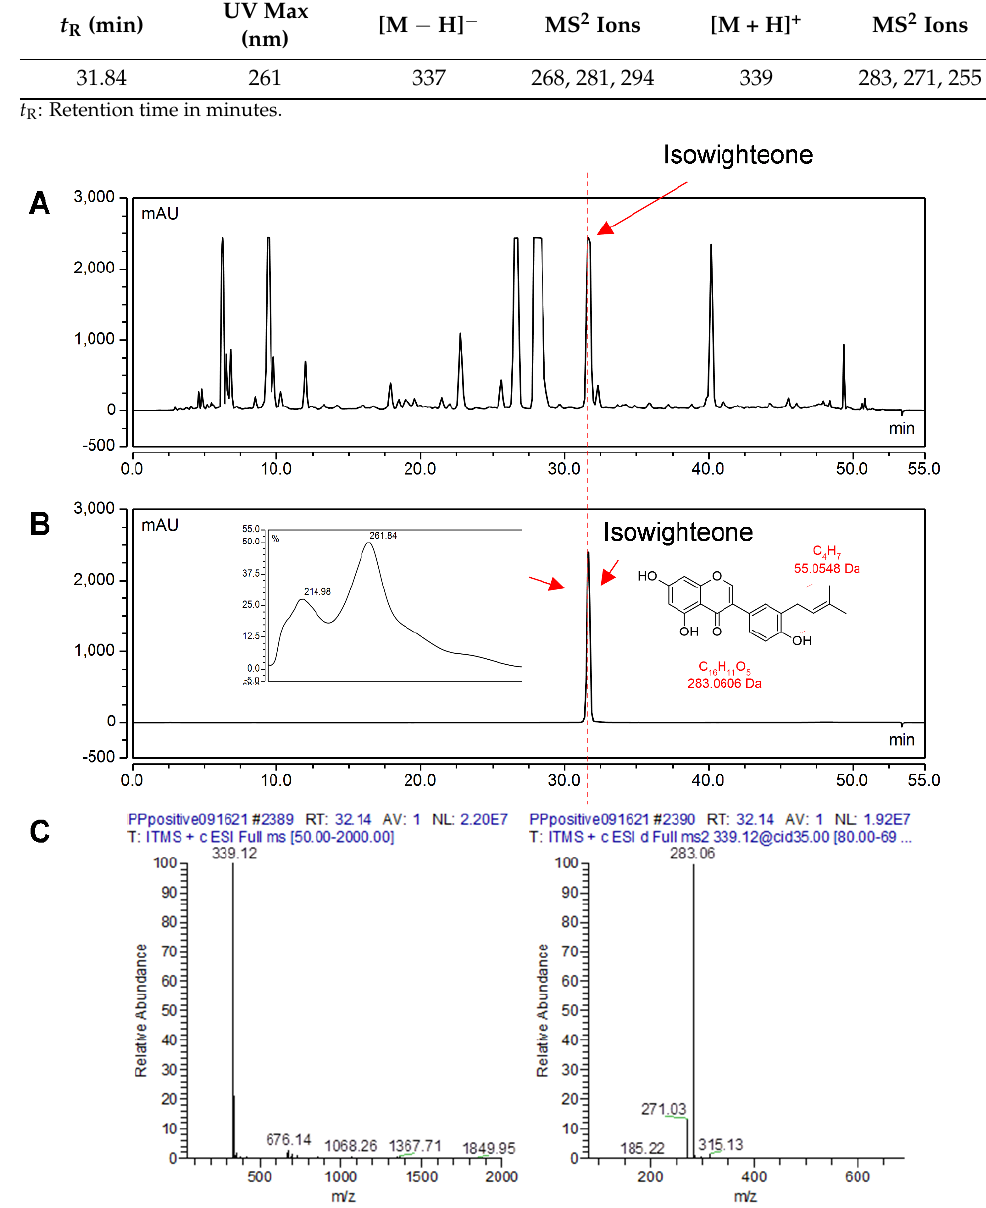
Figure 3. Purification of isowighteone. ( A ) HPLC chromatogram of ethyl acetate extract from the medium of pigeon pea hairy root culture. ( B ) HPLC chromatogram of purified isowighteone with its UV spectrum and chemical structure. All chromatograms were monitored at 260 nm. ( C ) HPLC- PDA-electrospray ionization-MS 2 analysis of isowighteone (left: MS; right: MS 2 ).